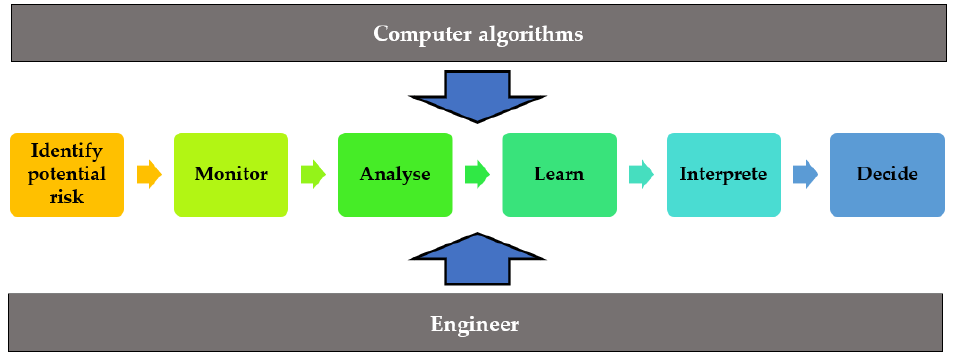
Figure 23. Key aspects of successful roof fall hazard risk management.